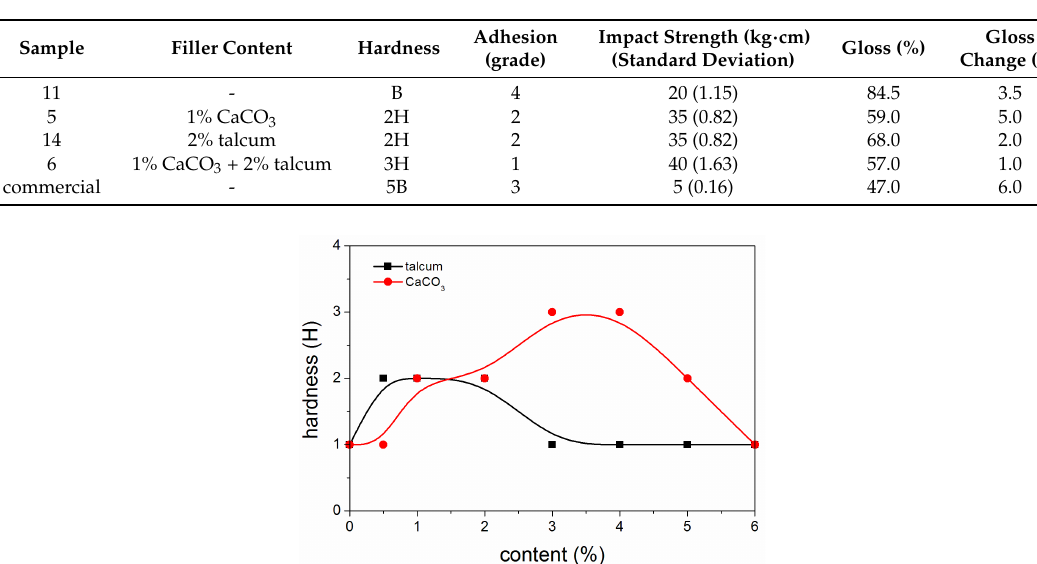
Table 9. Solvent resistance of WUVCW after exposition of 15% NaCl solution.